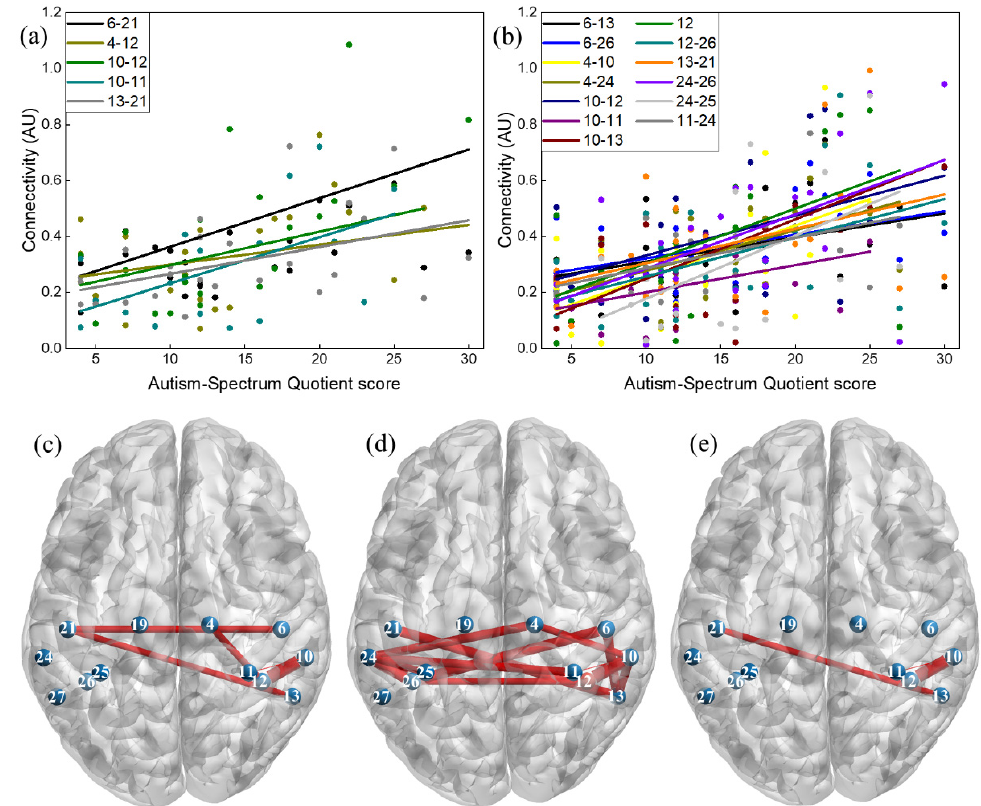
Figure 2. Mean connectivity during ( a ) Action-Execution, ( b ) Action-Observation. The edge thick- ness represents the connectivity strength. Red edge, node: connections which have significantly greater connectivity.